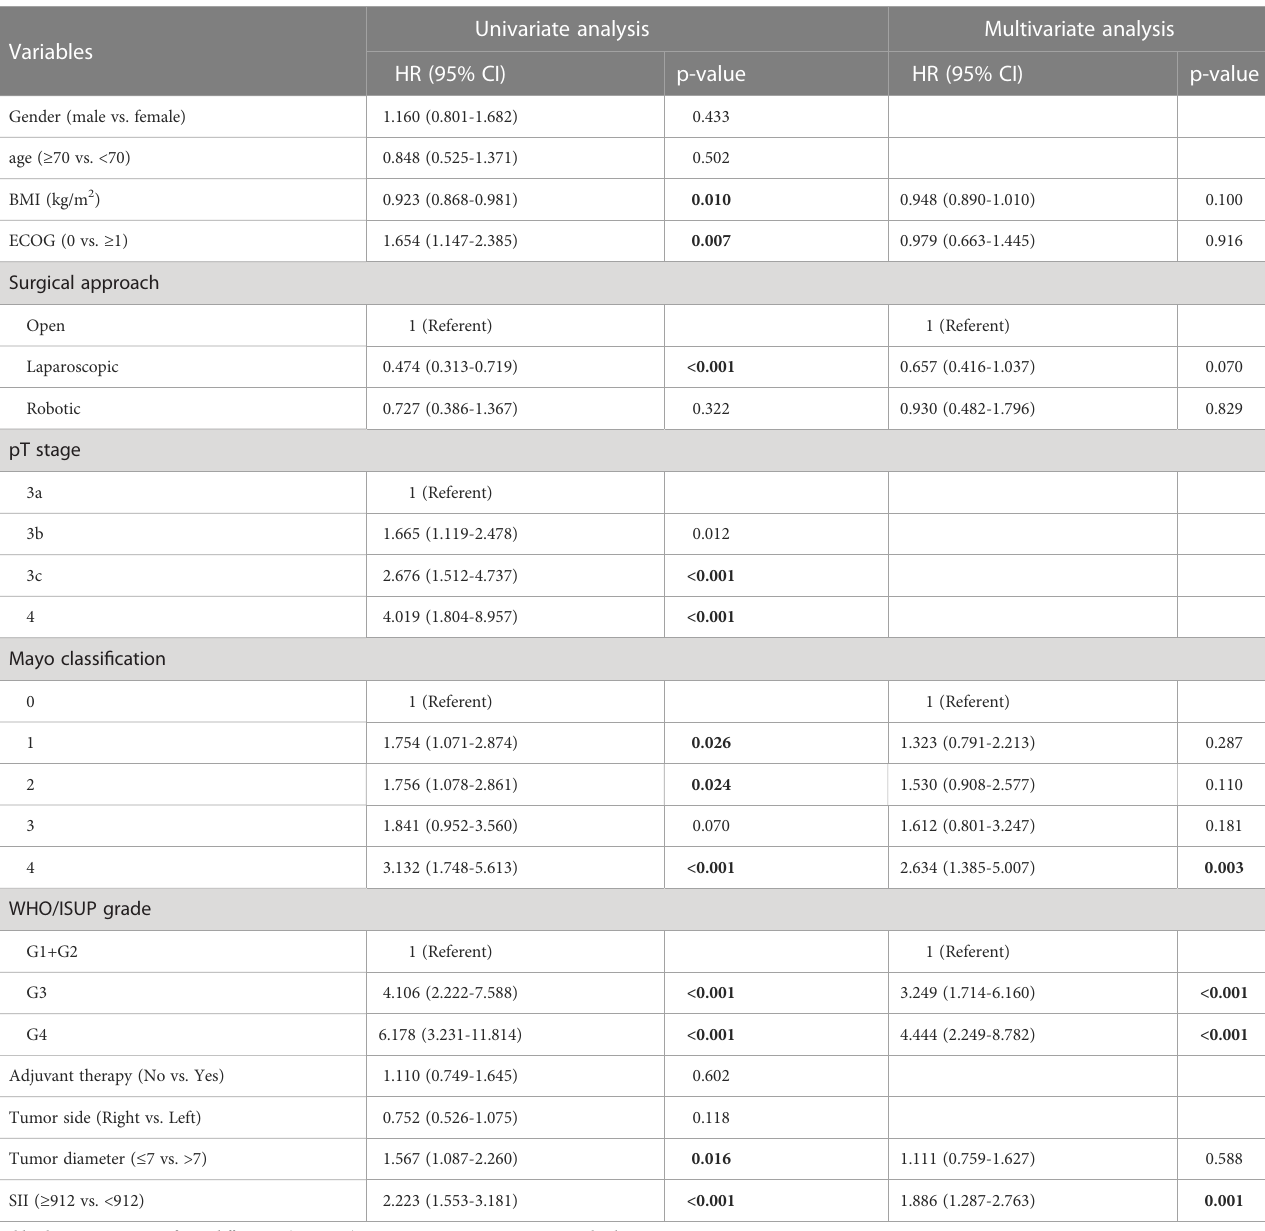
TABLE 3 Univariate and multivariate Cox analyses for DFS.